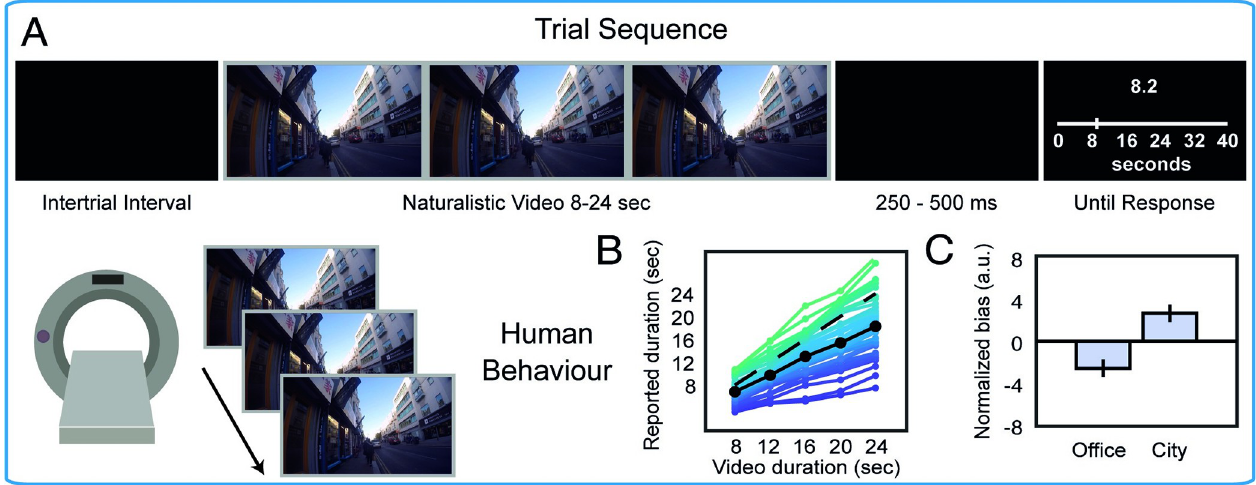
Fig 1. Trial sequence and human behavioral results. (A) Participants viewed naturalistic videos (8–24 seconds in duration, 1 video per trial) of walking around a busy city or sitting in a quiet office while in the MRI scanner and reported the duration using a visual analogue scale. (B) Participant-wise relationship between report and duration (colored lines), mean relationship (solid black line), and the line of unity (dashed line). (C) Relative under-/over-estimation of duration by human participants for office/city videos. Error bars represent +/- within-subject SEM.